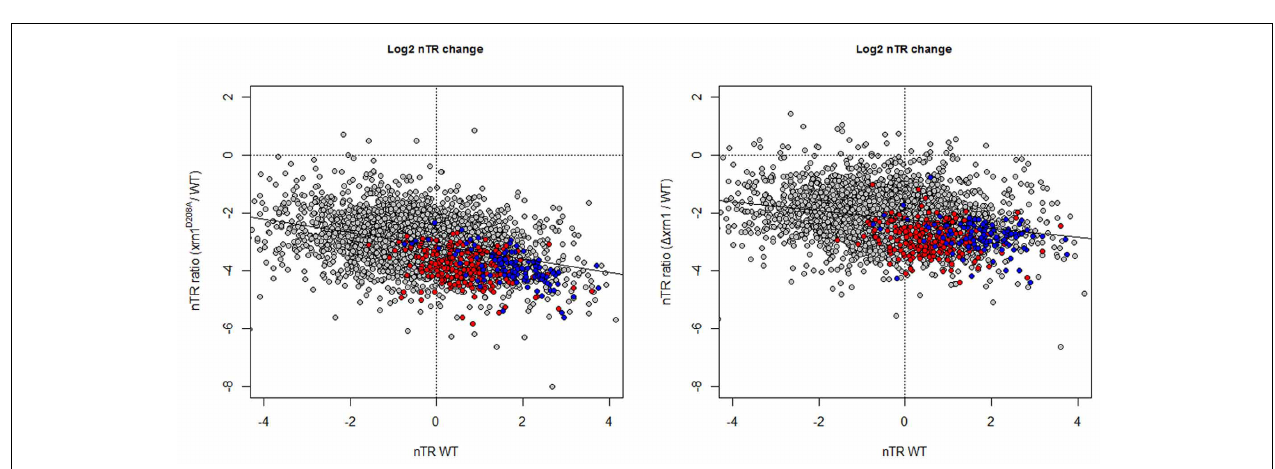
FIGURE 4 | Changes in the nTR level in xrn1 mutants inversely correlate with nTR. Plots of the ratios between mutant and wt nTR against nTR in the wt. nTR was determined as in García-Martínez et al. (2004). The median nTR